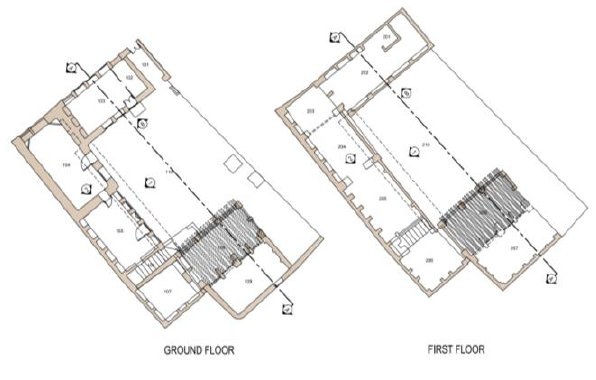
Figure 11 Aljazzaf house flooeplans. Example of generated 2D outcomes. Software employed Autodesk AutoCAD 2016. Images source Authors and Marwa Reyadh Alarayedh.